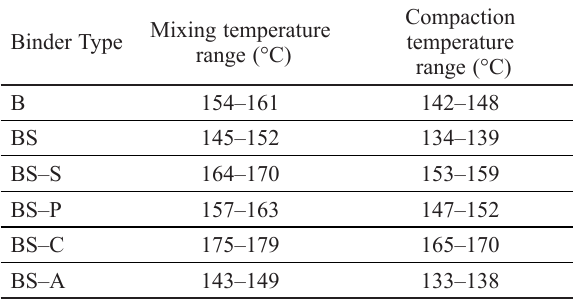
Fig. 7. G*/Sin δ for unaged bitumen binder at 1.59